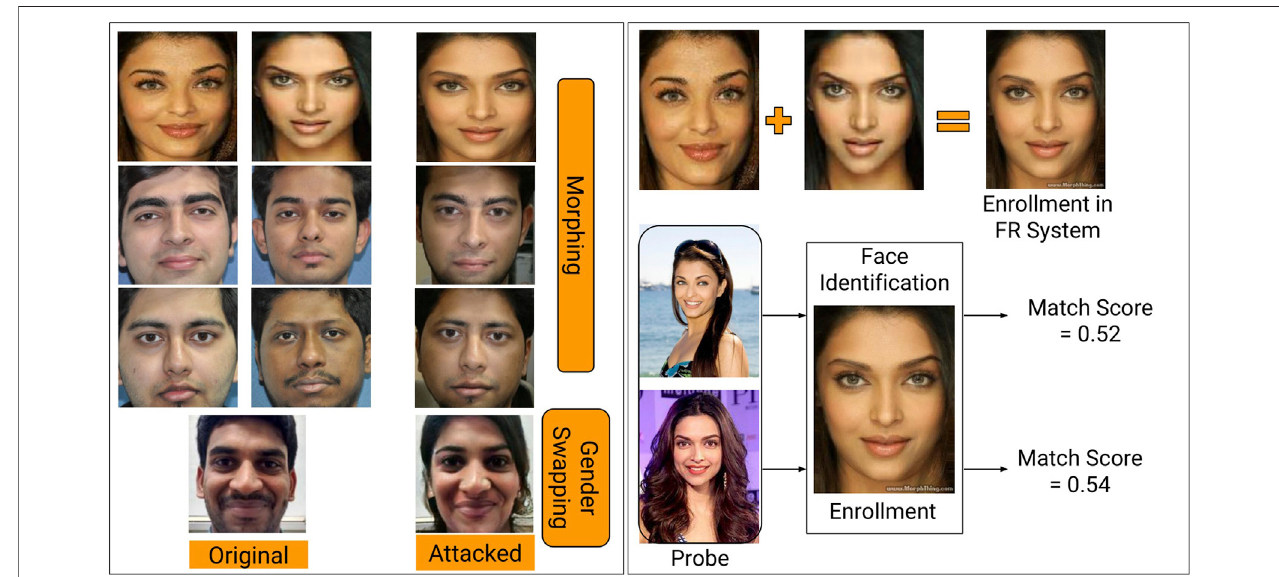
FIGURE 1 | (A) Illustrating the effect of perceptible digital alterations on face images (left) . (B) Illustrates the effect when enrolled templates are modi fi ed via morphing.The bottom row shows thatthe twodifferent identities can claim the same identity through enrolled morphed image. Experiments areperformed using COTS Face Recognition (FR) (right) . Human identi fi able images on the right side of the fi gure are taken from the